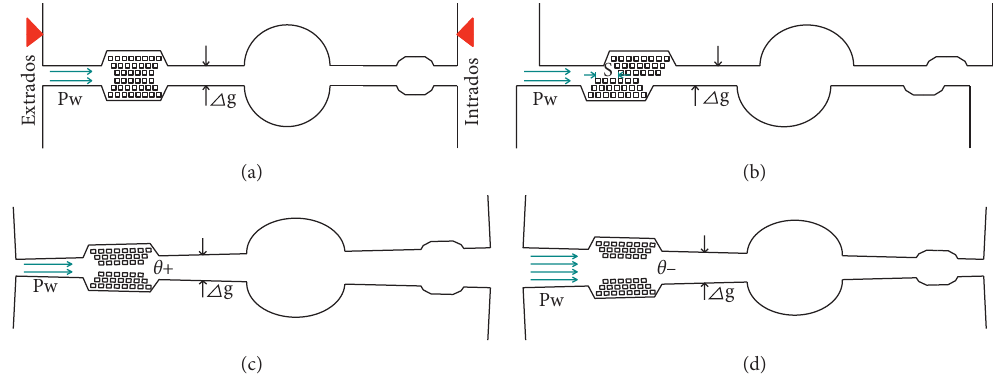
Figure 7: Failure patterns of joint waterproofing. (a) Opening of joint. (b) Offset of joint. (c) Positive joint rotation. (d) Negative joint rotation.